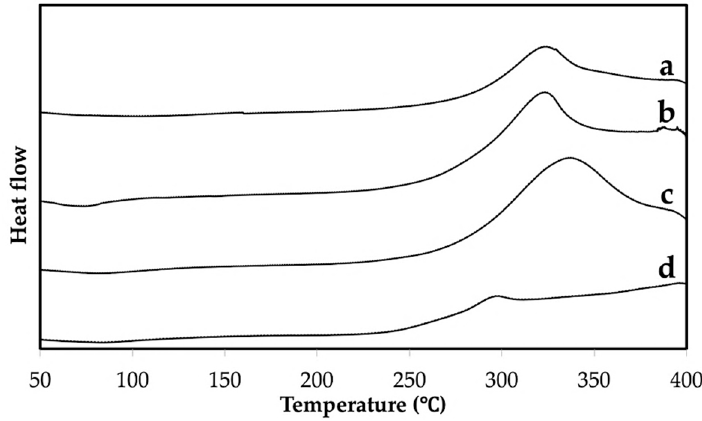
Figure 4. Differential scanning calorimetry (DSC) thermogram of crab shell ( a ), extracted chitin ( b ), commercial chitin ( c ), and commercial chitosan ( d ).